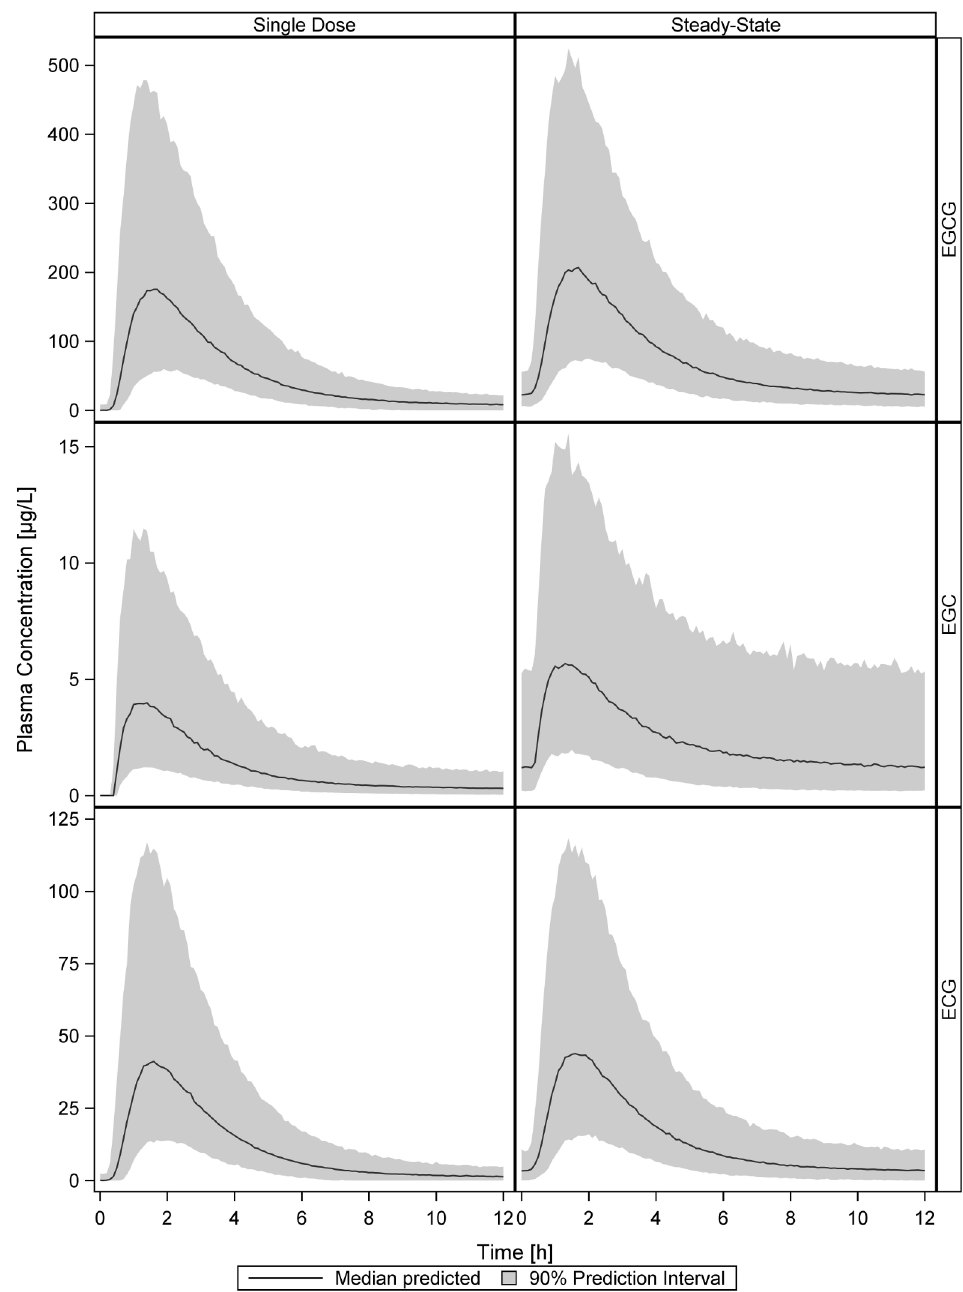
Fig 8. Simulation of single dose and steady-state plasma concentrations using the final PopPK model parameters of EGCG, EGC and ECG. Shown are the predicted medians (black lines) and corresponding 90% prediction intervals (shaded grey areas) of the simulation of 1000 individual plasma concentration-time profiles for each green tea catechin.